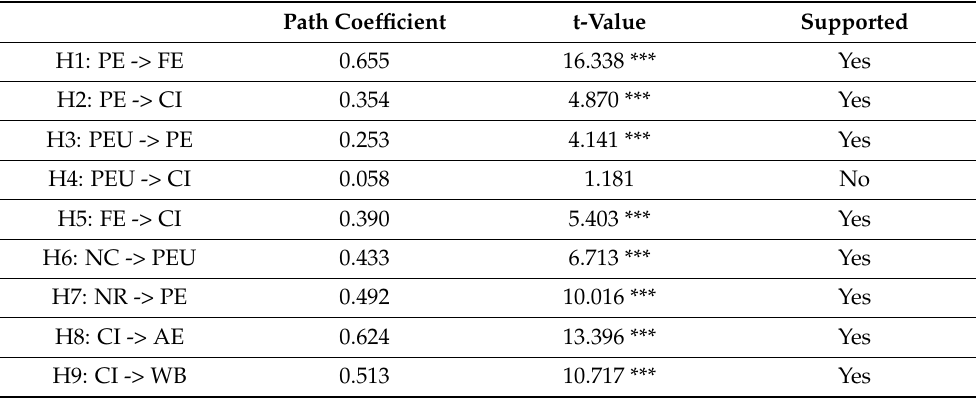
Table 5. Test of the